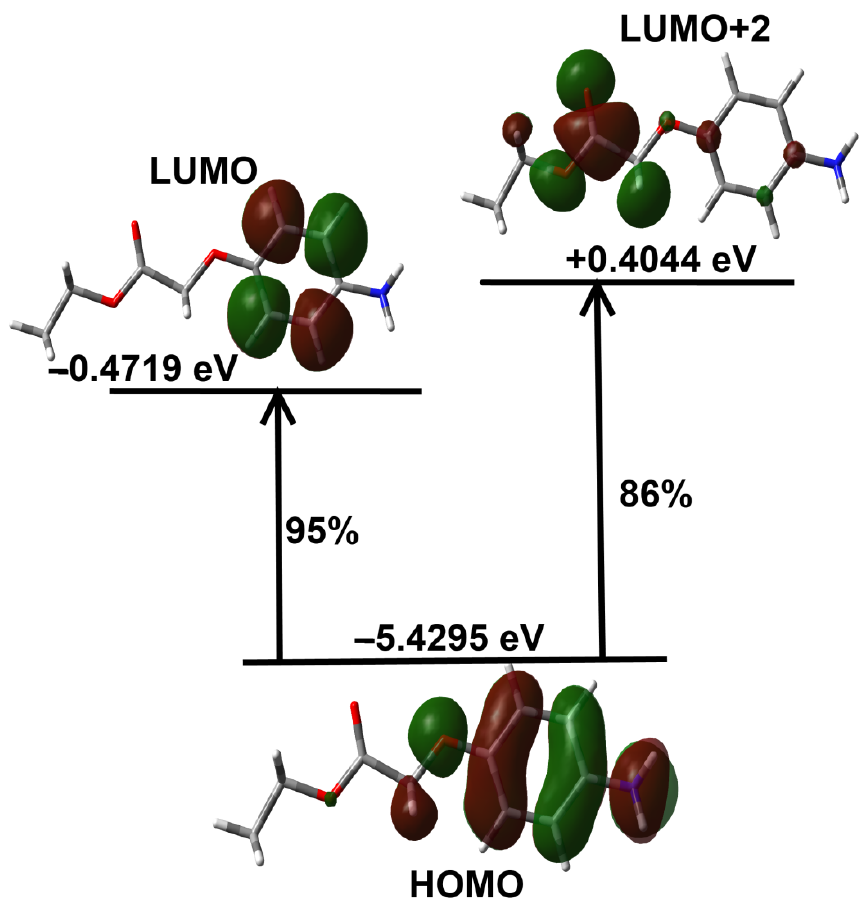
Figure 12. MOs contributed in the electronic absorption of 4 . Table 4. NBO electron delocalizations in 4